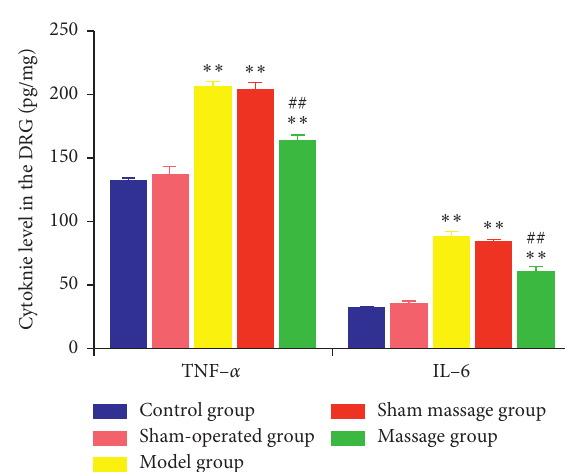
Figure 4: TNF- α and IL-6 expression 14 days after surgery. ∗∗ P < 0 . 0; compared with the control group; ## P < 0 . 01 compared with the model